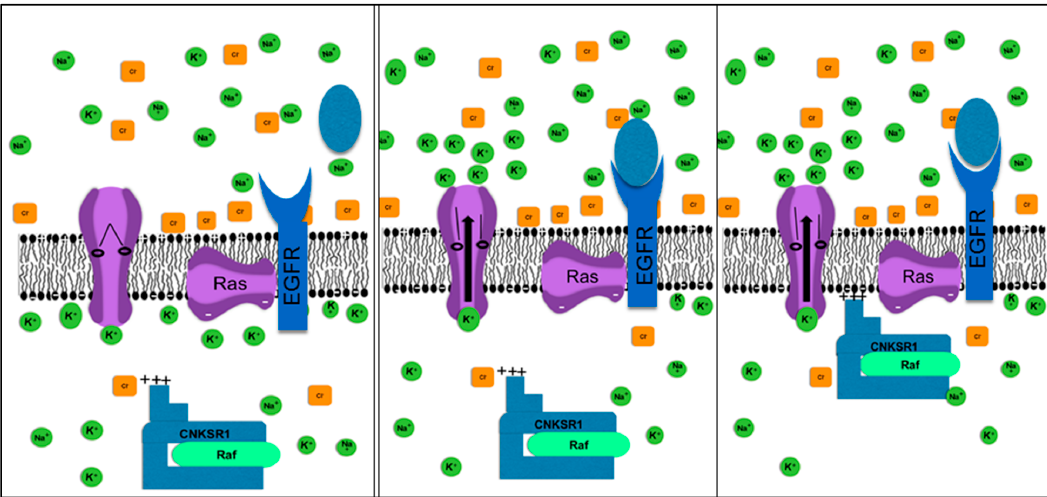
Figure 2. The role of ion dynamics in EGFR signaling. Ligand binding to EGFR activates Ras